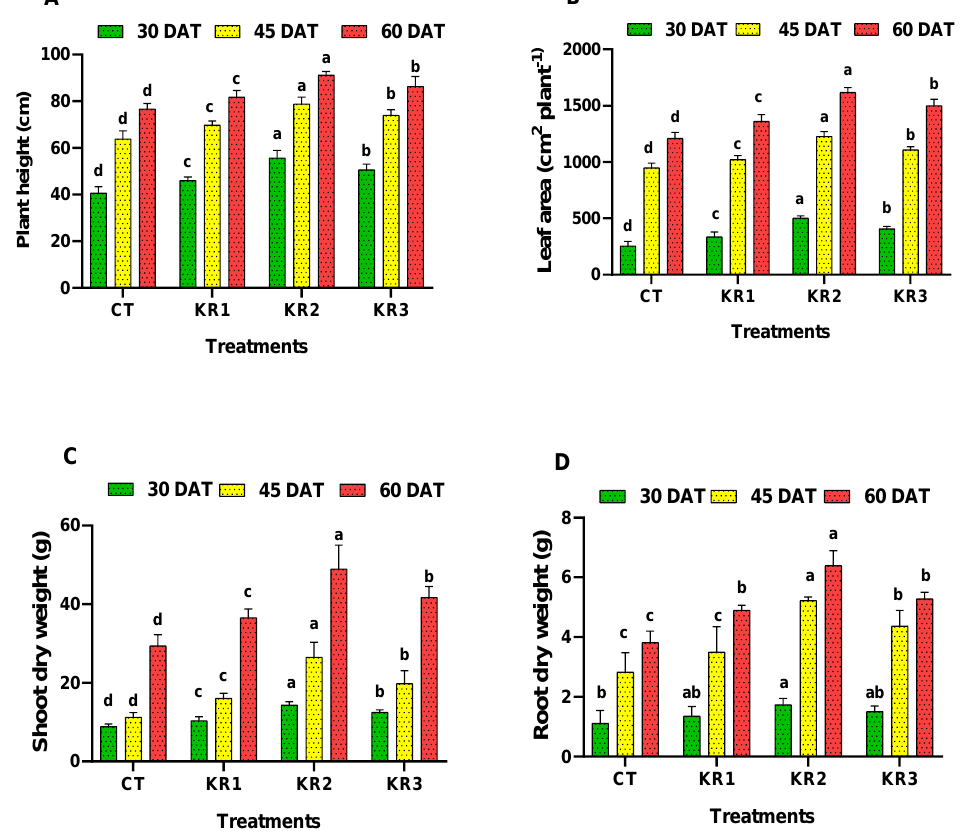
Figure 2. Growth parameters of tomato plants treated with Kendal Root biostimulant: ( A ) Plant height; ( B ) leaf area; ( C ) shoot dry weight; and ( D ) root dry weight. Data in the figure are expressed as mean ± SE. Mean values followed by the same letter do not differ significantly at p ≤ 0.05 by DMRT.